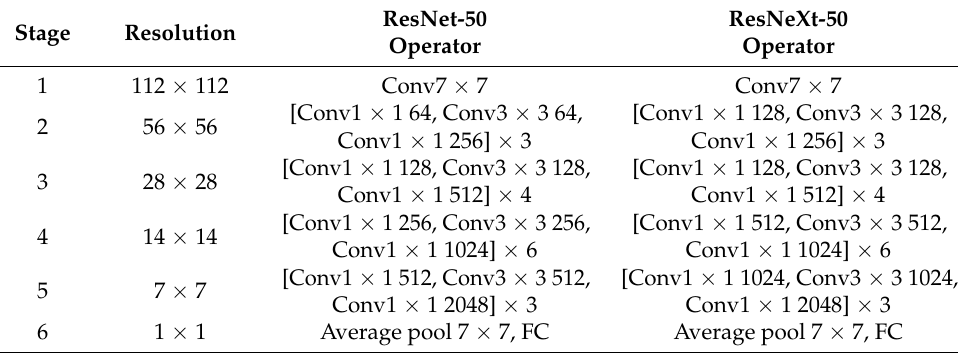
Table 7. Detailed configuration of the ResNet and ResNeXt.